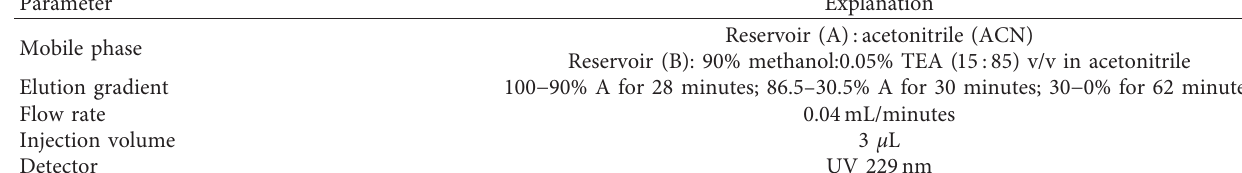
Table 6: HPLC conditions for the imprinted monolithic column.